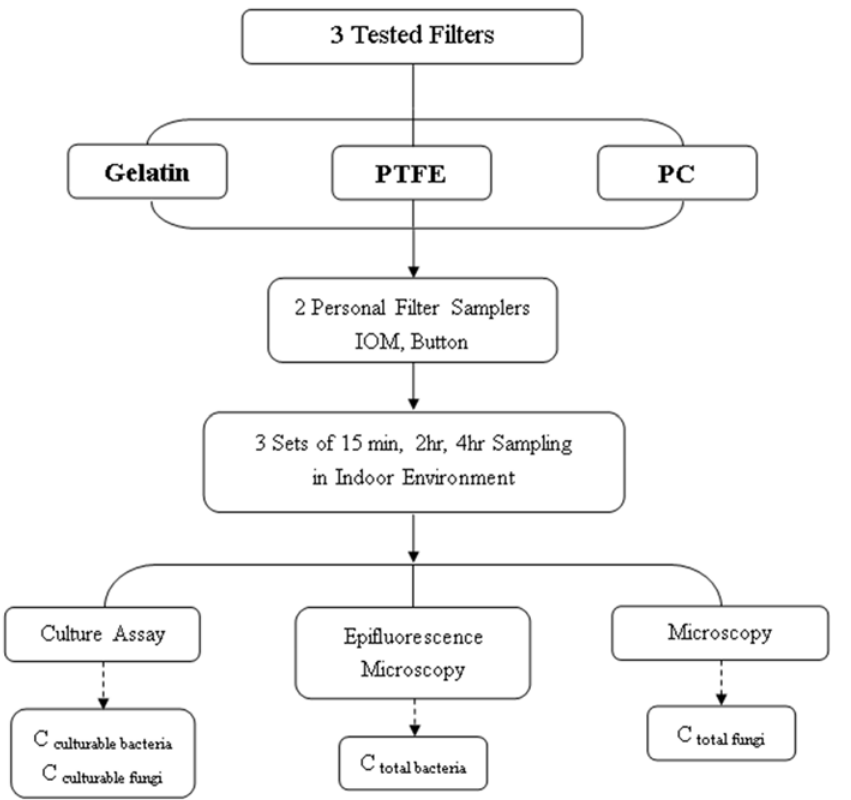
Fig 1. Flowchart for filter